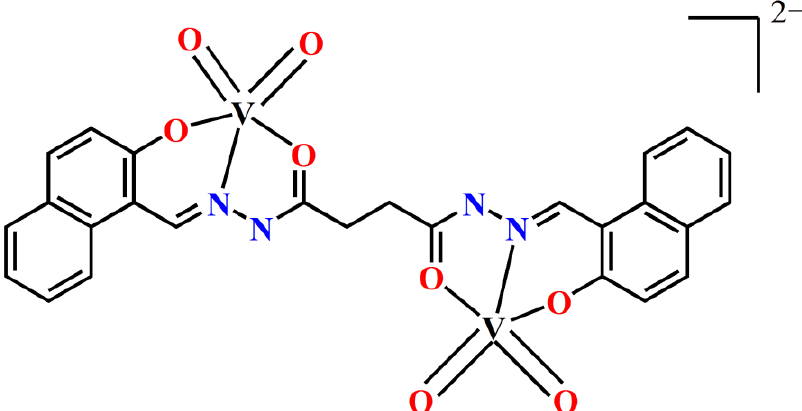
Figure 57. A symmetrical binuclear vanadium(V) complex of a special dinaphthylhydrazone ligand linked by the condensation of 1,4-succinylhydrazine with two